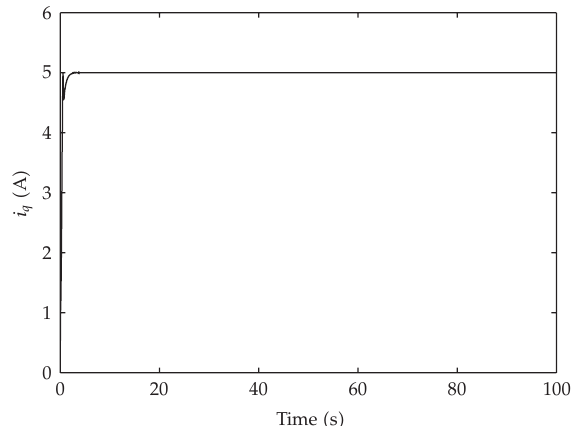
Figure 6: The i q curve of the chaotic PMSM drive system with u d